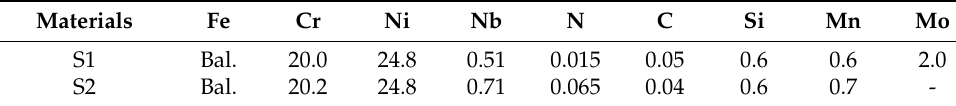
Table 1. Chemical compositions of the materials used in this work